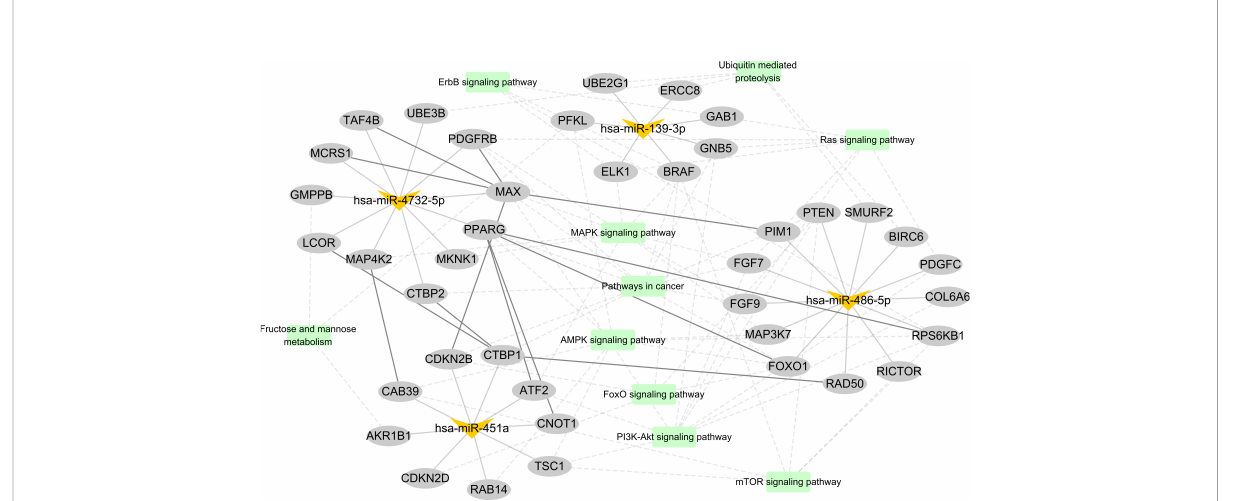
FIGURE 6 The candidate miRNA – mRNA interaction network. In this graphic, miRNAs, mRNAs, and KEGG pathways are represented with V shapes, ellipses, and rectangles, respectively. The thick solid lines represent protein – protein interactions from STRING database, the thin solid lines represent miRNA – target gene pairs, and the dotted lines represent the connected gene belonging to the KEGG